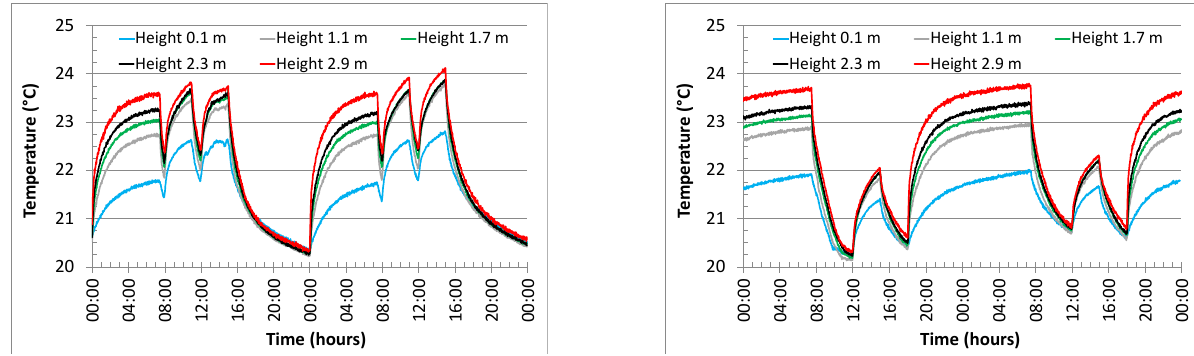
Figure 13. Measured vertical temperature profiles for Scenario I ( left ) and Scenario II ( right ) of the lab test. Figure 14 presents the vertical temperature distribution in the floor slab at the depths of 0, 4, and 8 cm below the floor level for the two test scenarios. Each curve represents an average of four thermocouples installed at the same depths in different positions in the room. In both scenarios, the slab temperatures increased with time in the heating mode, and its thermal mass was charged. The slab temperatures also increased in the day oper- ating mode, but at different rates, as occupancy levels were dissimilar for the two scenar- ios. The discharging occurred in non-occupancy periods when the airflow to the test setup was reduced to zero. Throughout the experiment, temperatures at 8 cm depth remain no- ticeably higher than the temperatures at 0 and 4 cm depths.